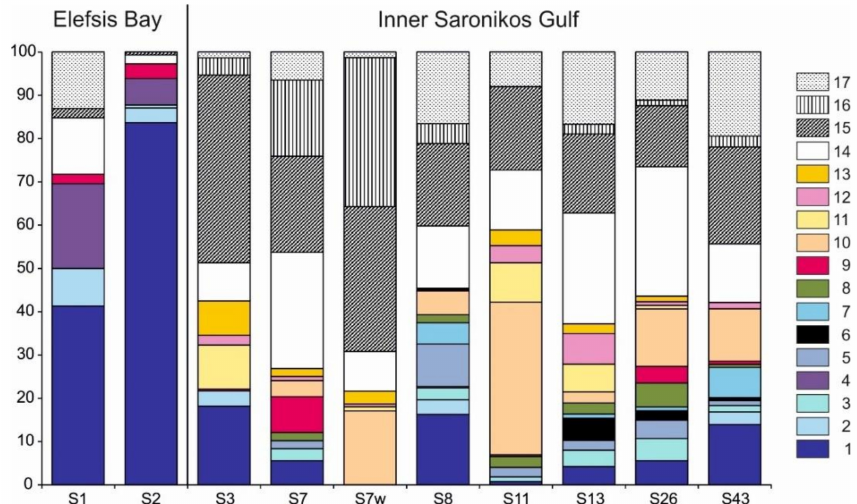
Figure 5. Frequencies of the most abundant foraminiferal taxa. 1 Bulimina elongata ; 2 Bulimina marginata ; 3 Bolivina spathulata ; 4 Nonionella turgida ; 5 Melonis barleeanum ; 6 Cassidulina carinata ; 7 Hyalinea balthica ; 8 Hanzawaia boueana ; 9 Ammonia tepida ; 10 Elphidium crispum ; 11 Asterigerinata mamilla ; 12 Cibicides lobatulus ; 13 Rosalina bradyi ; 14 other hyaline species; 15 miliolids; 16 Peneroplis spp.; 17